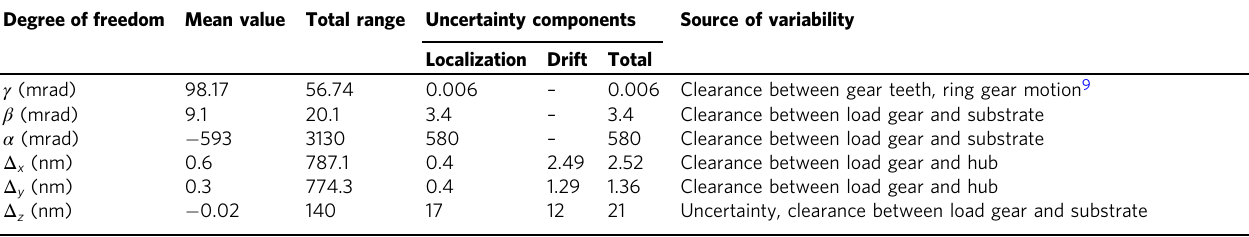
Table 1 Motion variability due to mechanical play. Degree of freedom Mean value Total range Uncertainty